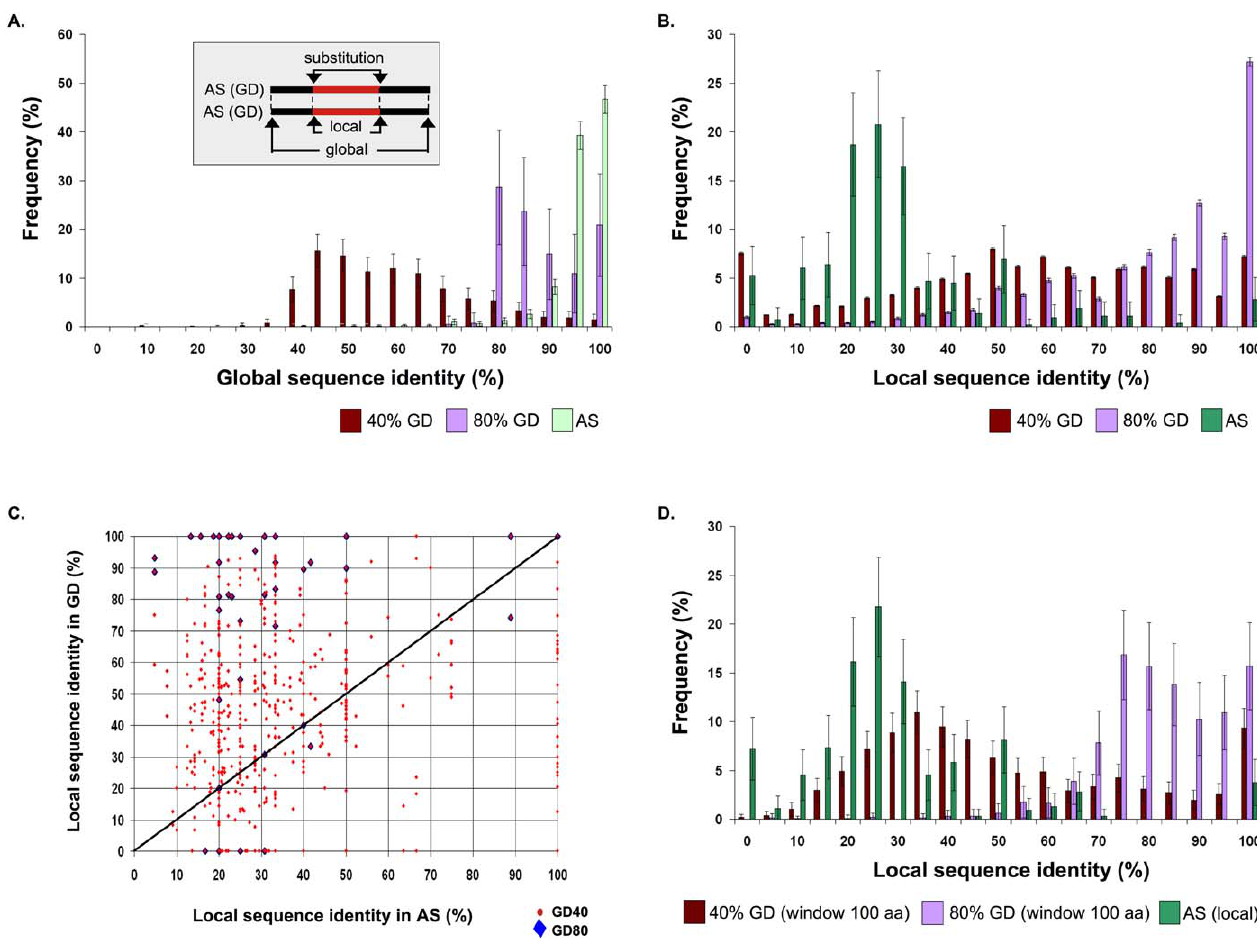
Figure 3. Global and Local Sequence Identity in AS and GD Substitutions AS data were obtained by querying SwissProt [44] database version 40, with the keywords VARSPLIC and HUMAN. GD data were obtained by clustering the SwissProt [44] data using CD-HIT [47] to 40% or 80% seq.id. (GD40 and GD80, respectively). We focus on AS þ /GD þ cases, i.e., those sequences with both AS and GD, in Figure 3A–3C, and discuss the AS (cid:2) /GD þ versus AS þ /GD (cid:2) case in Figure 3D. (A) Global seq.id. The seq.id. in GD families depends on the cutoff used for clustering, e.g., GD40 (dark red) or GD80 (light violet), respectively. The global seq.id. between alternative splice isoforms (light green) is very high ( . 90% seq.id.), reflecting the underlying nature of AS changes. (B) Local seq.id. in alternative splice isoforms (dark green) is measured between substituted stretches, usually arising from mutually exclusive exons. The local seq.id. between gene duplicates is obtained using a moving window (GD80: light violet, GD40: dark red) and reporting the seq.id. observed in all possible window positions. (C) Local seq.id. in AS and GD at equivalent positions. The graph compares local seq.id. found in alternative splice variants of a gene with the local seq.id. of a duplicate of the same gene. The AS local seq.id. was computed between substituted sequence stretches. For GD, we mapped the sequence positions of the AS event to the aligned GD, and computed the seq.id. between the GD, considering only the aligned positions within that region. The comparison is shown for AS and GD40 (red) and GD80 (blue), respectively. The diagonal separates the plot into two halves: the upper half corresponds to the region for which GD seq.id. is higher than that for AS; the lower half corresponds to the opposite. For both types of gene families (GD40 and GD80), most substitutions show higher seq.id. amongst gene duplicates than amongst alternative splice variants, and this bias is significant (GD80: 111 of 142, v 2 test p -value , 1.9 3 10 (cid:2) 11 ; and 492 of 786, v 2 test p -value , 6.5 3 10 (cid:2) 15 , respectively). This result confirms the overall distributions examined in Figure 3B: changes in AS are stronger and more localized than those in GD. (D) Local seq.id. in AS (cid:2) /GD þ and AS þ /GD (cid:2) substitutions. To compute local seq.id. in AS (cid:2) /GD þ families, we first align two GD, then slide a 100-aa window over the sequence of one protein, and compute the seq.id. at all sequence positions of the window. The results of all the possible comparisons are plotted for GD40 (dark red) and GD80 (light violet) families. For genes with AS but no duplicates (AS þ /GD (cid:2) ) (dark green), local seq.id. was computed between the two substituted stretches resulting from AS events. As for AS þ /GD þ families (Figure 3B), we find that, in general, local seq.id.s are substantially lower for AS events (AS þ /GD (cid:2) ) than for GD (AS (cid:2) /GD þ families). The overlap between the AS and GD40 families is higher than that between AS and GD80 families, which may partly be due to differences in the structure constraints applying to the proteins in each